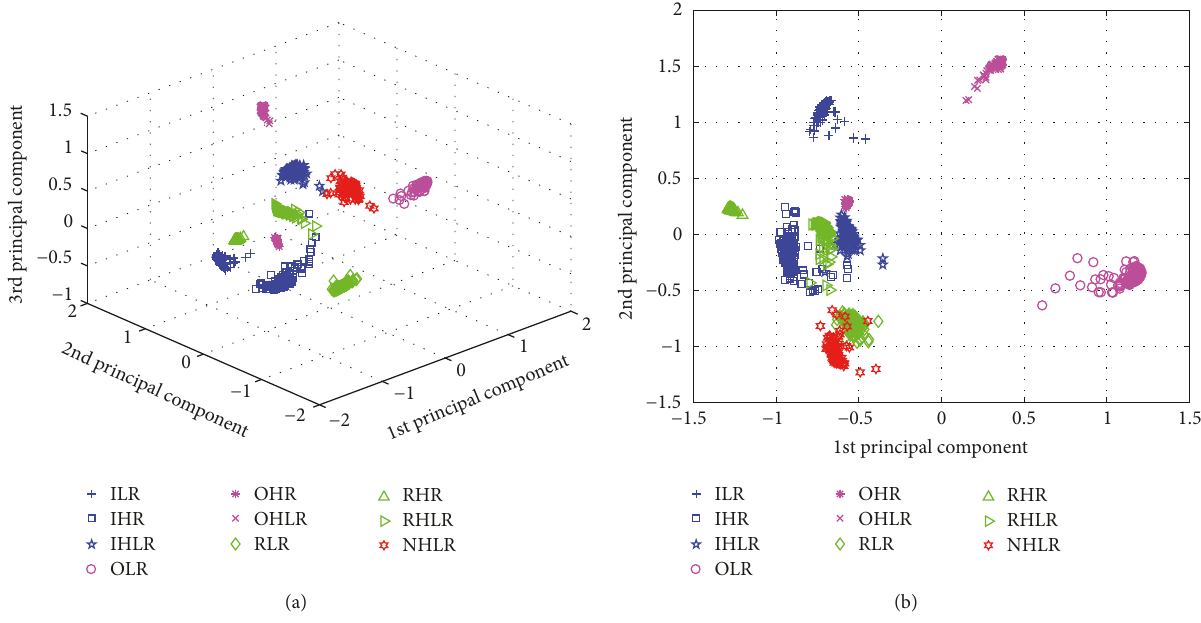
Figure 16: Feature visualization maps of the proposed method in Experiment 3. (a) The first three PCs; (b) the first two PCs.